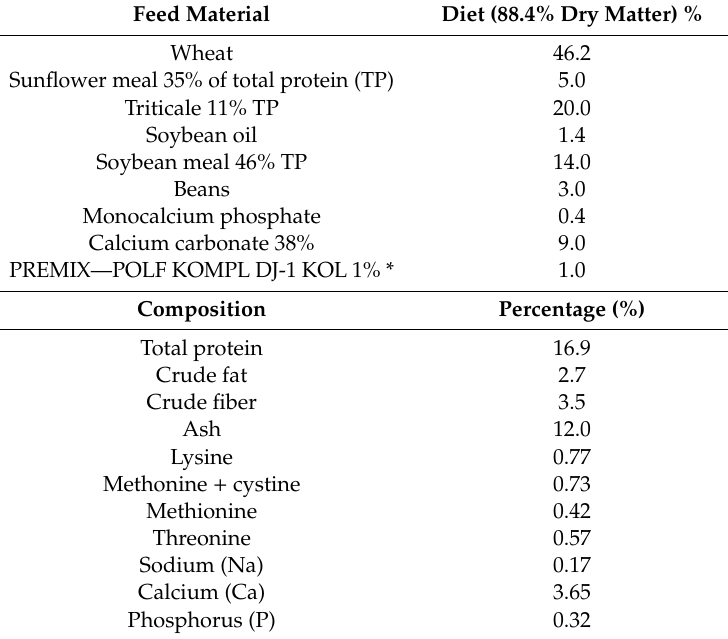
Table 2. Ingredients and chemical composition of basal diet